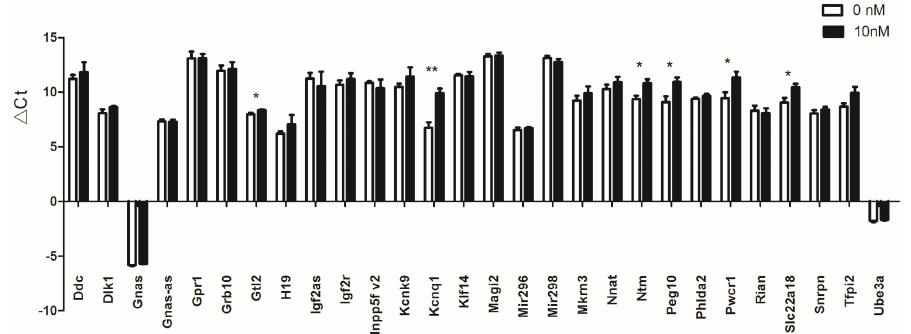
Figure 2. Expression profile of 28 imprinted genes both expressed in control and GNRs treated TM-4 cells. Data are expressed as the mean ± SEM. X axis indicates the names of the imprinted genes both expressed in control and GNRs treated TM-4 cells. Y axis indicates the delta CT values for each imprinted genes ( △ Ct = Ct imprinted gene – Ct gapdh /U6 ). Sample number = 4, * p < 0.05; ** p < 0.01 vs. control.